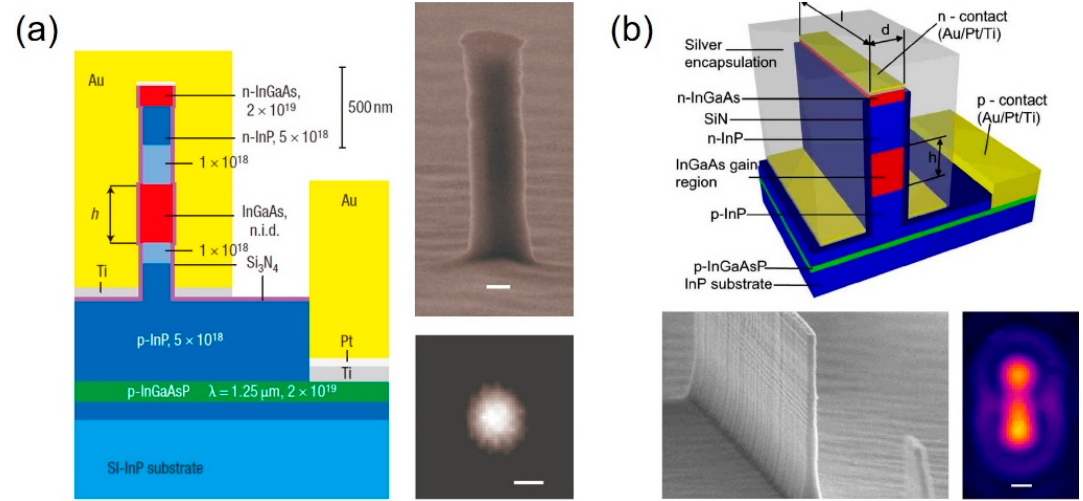
Figure 9. Electrically driven metal-encapsulated nanocavity nanolasers. ( a ) Metallic nanocavity laser. Schematic showing Au-encapsulated InP/InGaAs/InP pillar cavity structure (left). SEM image of fabricated laser (right, top) and IR camera image of lasing mode (right, bottom) [40]. Figure reproduced with permission from Springer Nature Limited. ( b ) Electrically driven metal-insulator-metal (MIM) sub-wavelength plasmonic waveguide lasers. Schematic of the device layer structure (top). A vertically p - i - n -doped rectangular InP/InGaAs/InP semiconductor pillar coated with silicon nitride is contact-metallized and encapsulated in silver. SEM image of vertical rectangular pillar before silicon nitride coating (left, bottom). IR camera image of the lasing mode for above threshold current of 320 µ A (right, bottom) [41]. Figure reproduced with permission from Optical Society of America.